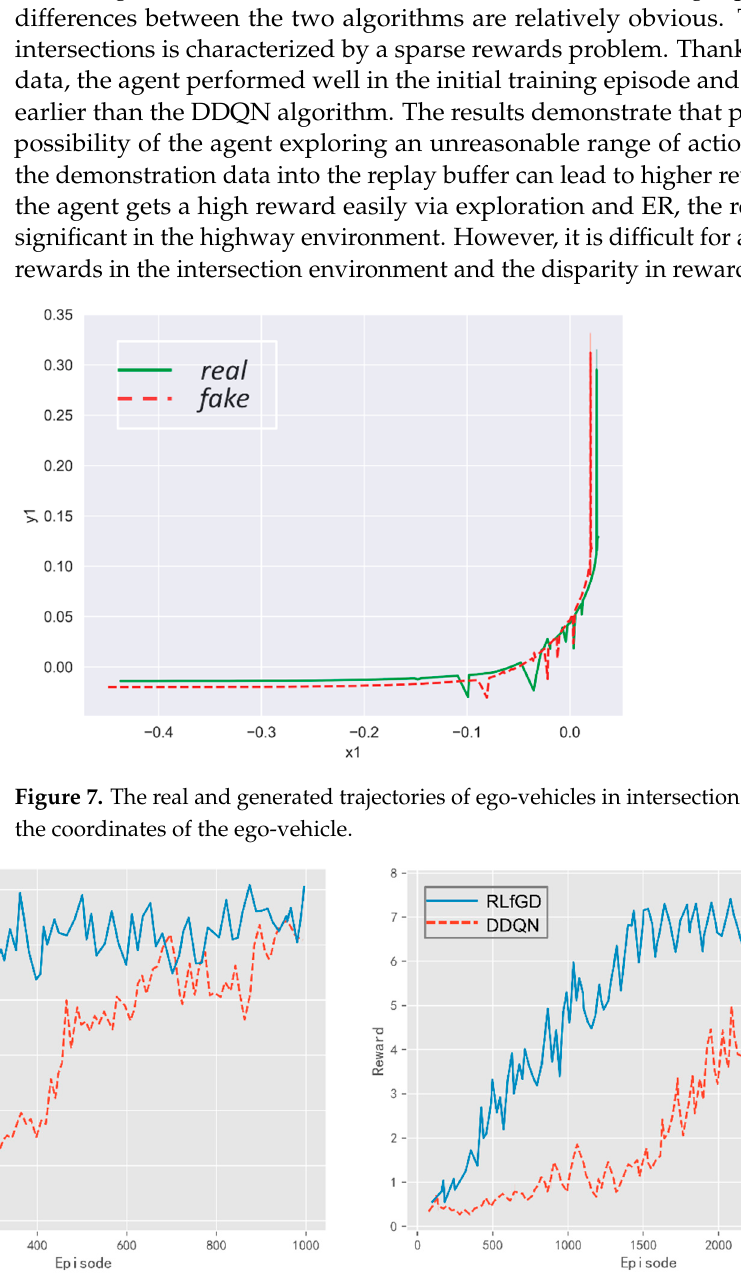
Figure 6. In the histogram of partially generated data and real data, Figures ( a , b ) are the longitudinal speed of the vehicle at the intersection ( a ) and highway ( b ) environment; Figures ( c , d ) are the lateral speed of the vehicle at the intersection ( c ) and highway ( d ) environment. The vehicle’s lateral and longitudinal speeds are normalized.